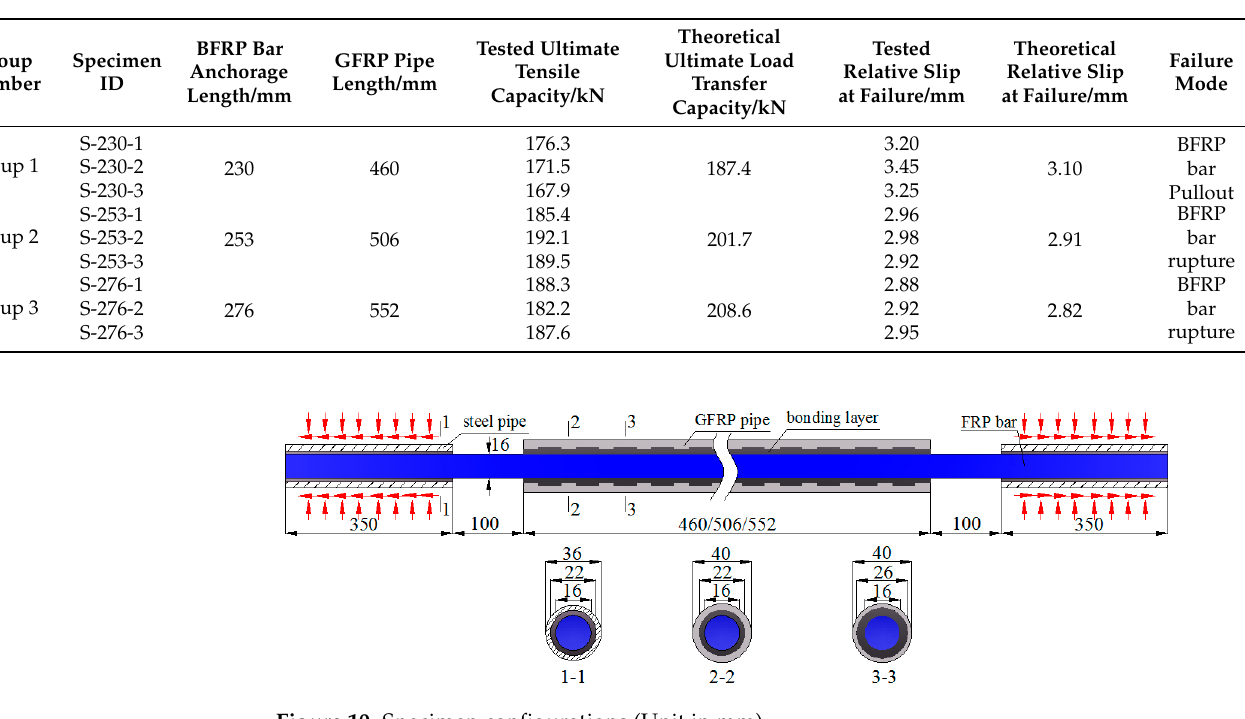
Table 3. Specimen details and the corresponding tested results.